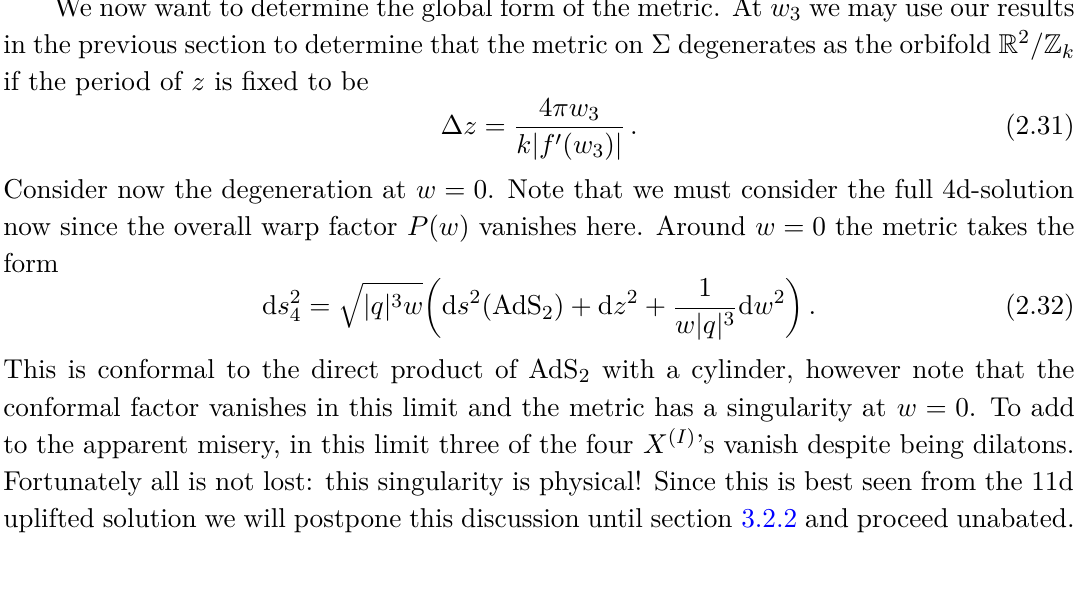
(cid:2) (cid:1) − 2 , 0 √ 3 3